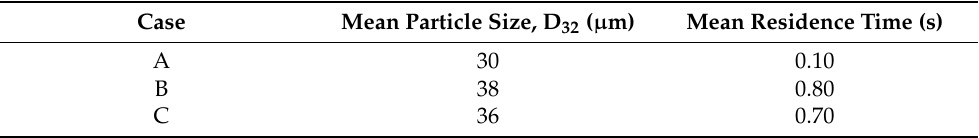
Table 4. Particle mean diameter and mean residence time at